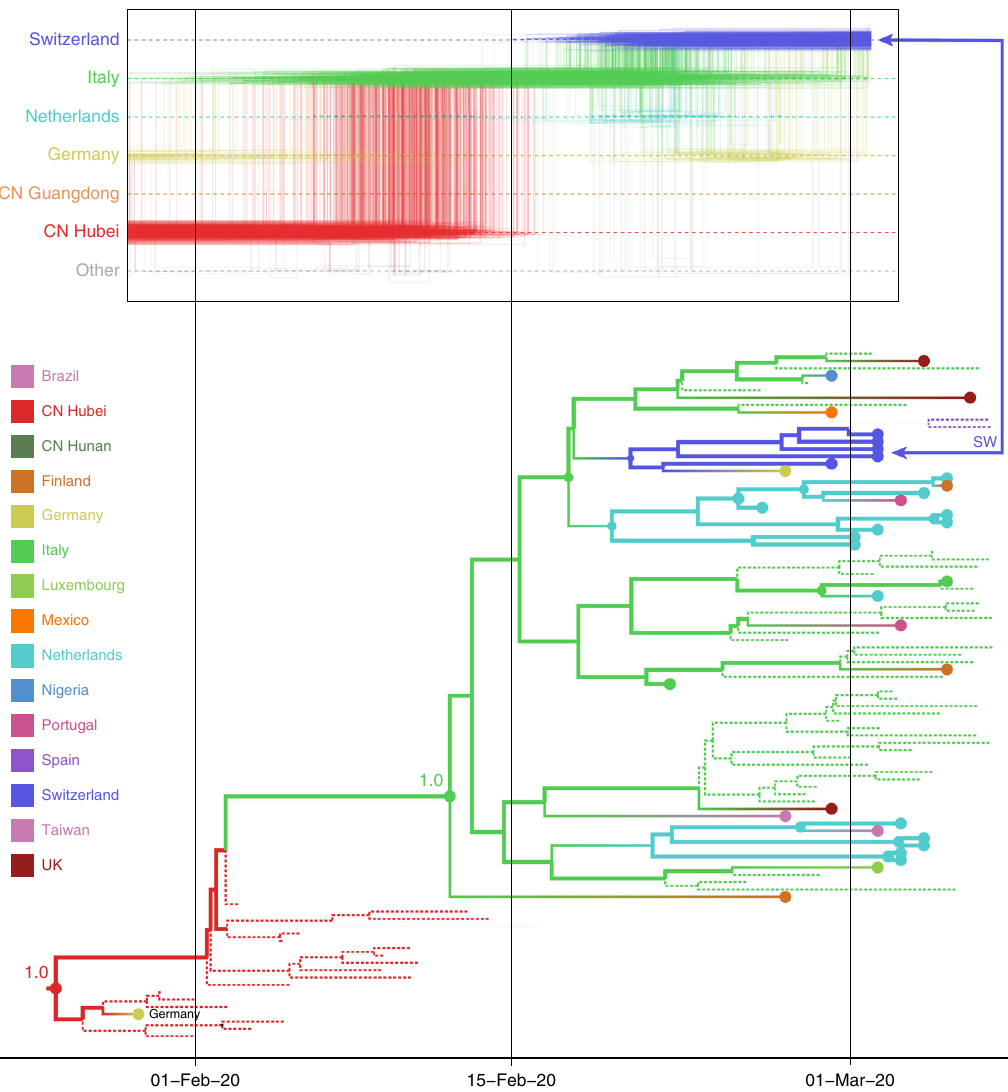
Fig. 4 Markov jump trajectory plot as in Fig. 3 for a Swiss genome (EPI_ISL_413021) in lineage B1, and B1 subtree for the Bayesian phylogeographic analysis incorporating travel data and unsampled diversity. Dotted lines represent branches associated with unsampled taxa assigned to Italy and Hubei, China. The tip for the Swiss genome corresponding to the trajectory is indicated with an arrow. The basal German virus is labeled. The value at the root and the common ancestor of the Italian clade represents the posterior location